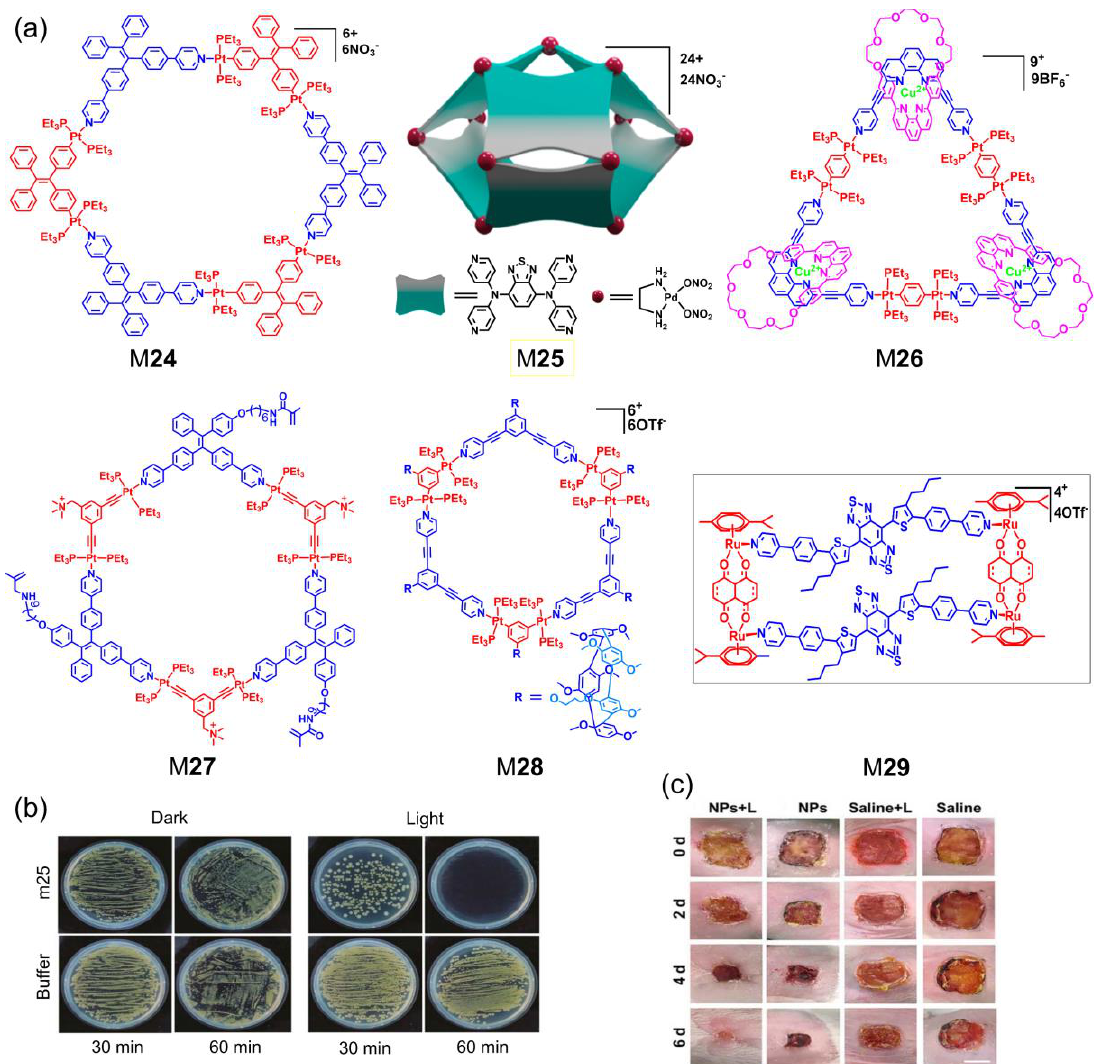
Figure 5. The antibacterial performance of metallacycles and metallacages. ( a ) The structures of M 24 − M 29 . ( b ) Pictures of the bacterial colonies of S. bacteria after exposure to M 25 in 0.1 M acetate buffer with white light irradiation. ( c ) Photographs showing the infected wound after different treatments. Adapted with permission from refs. 85 – 90. Copyright 2019 and 2022 National Academy of Sciences (USA); 2020 and 2022 Wiley-VCH; 2020 Nature Publishing Group; 2020 American Chemical Society.